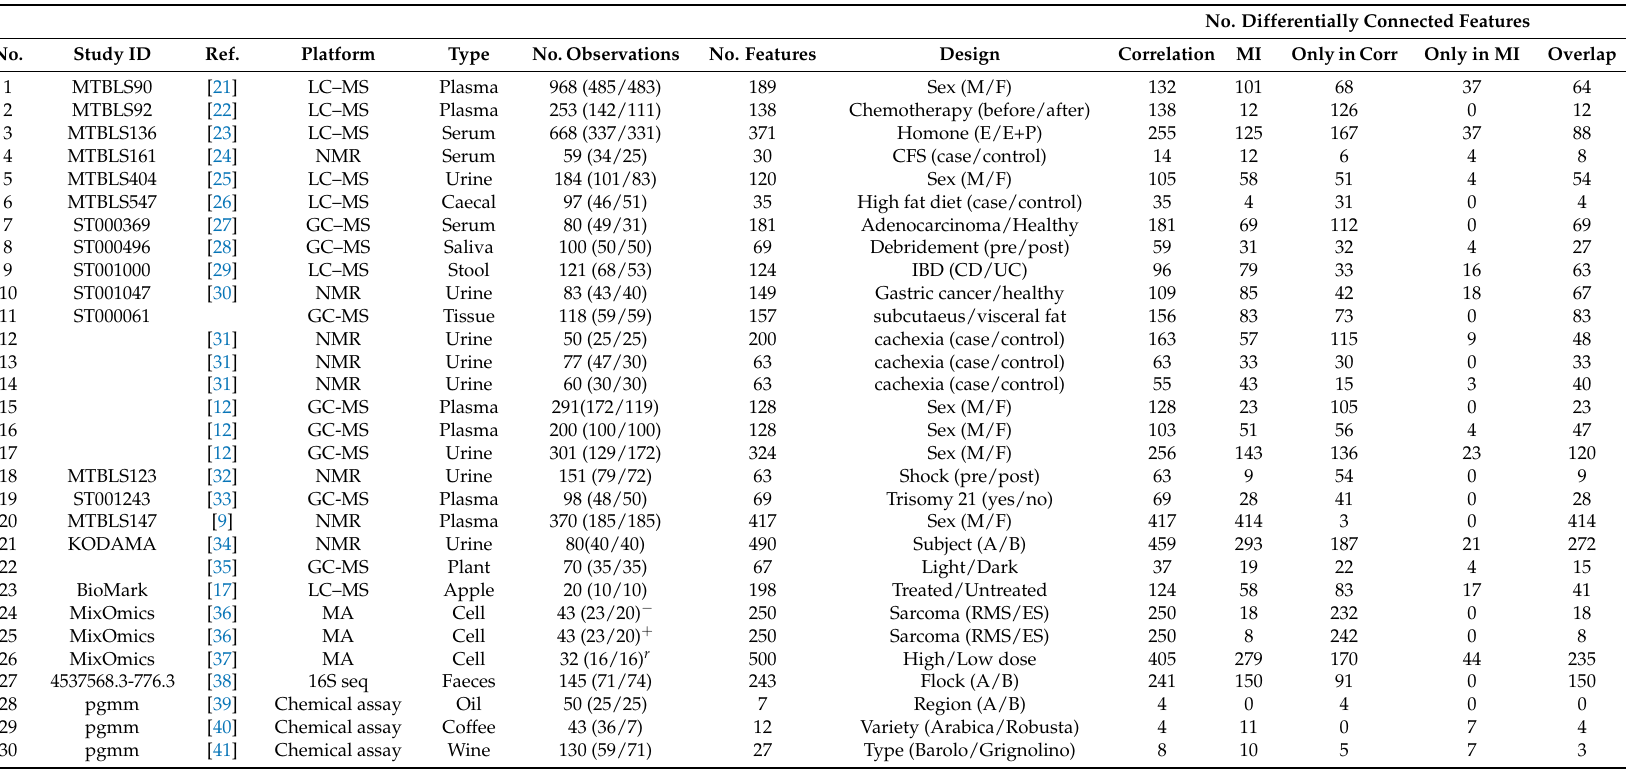
Table 1. Correlation and MI indicate the number of features found to be statistically significantly differentially connected (at the α = 0.05 level using correlation and MI as measure of association). Only in correlation and Only in MI denote differentially connected features found only using correlation and MI, respectively. Overlap indicates those found by both methods. The number of observation (No. observations) is n = n 1 + n 2 , where n 1 and n 2 is the sample size of group 1 and 2, respectively. Study IDs starting with MTBL indicate data available in Metabolights database [14] (www.ebi.ac.uk/metabolights), while those starting with ST indicate data